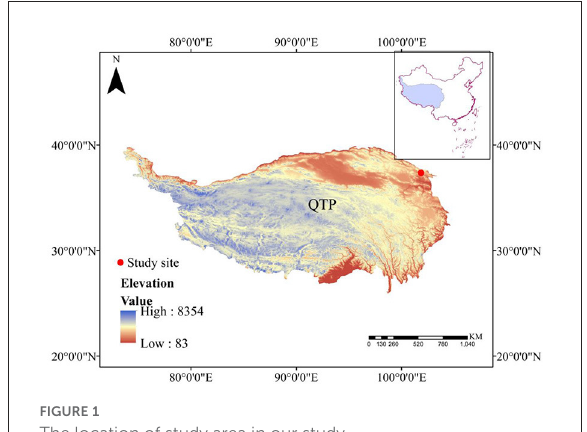
FIGURE1 The location of study area in our